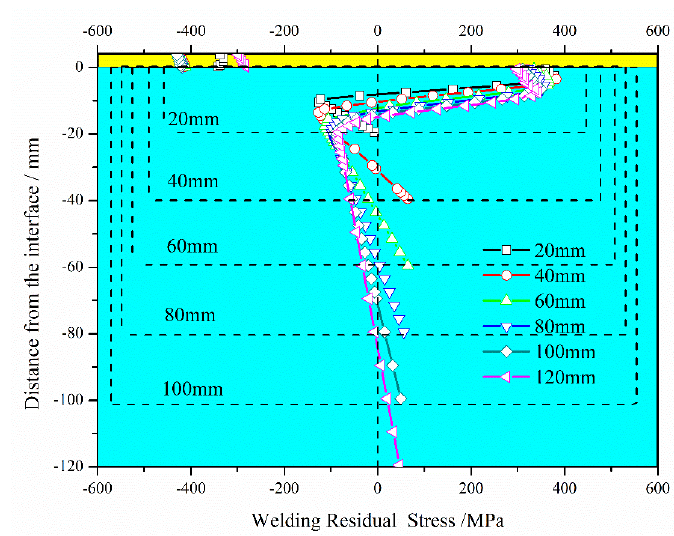
Figure 16. Final WRS for different thicknesses of 2.25Cr–1Mo–0.25V steel substrate.